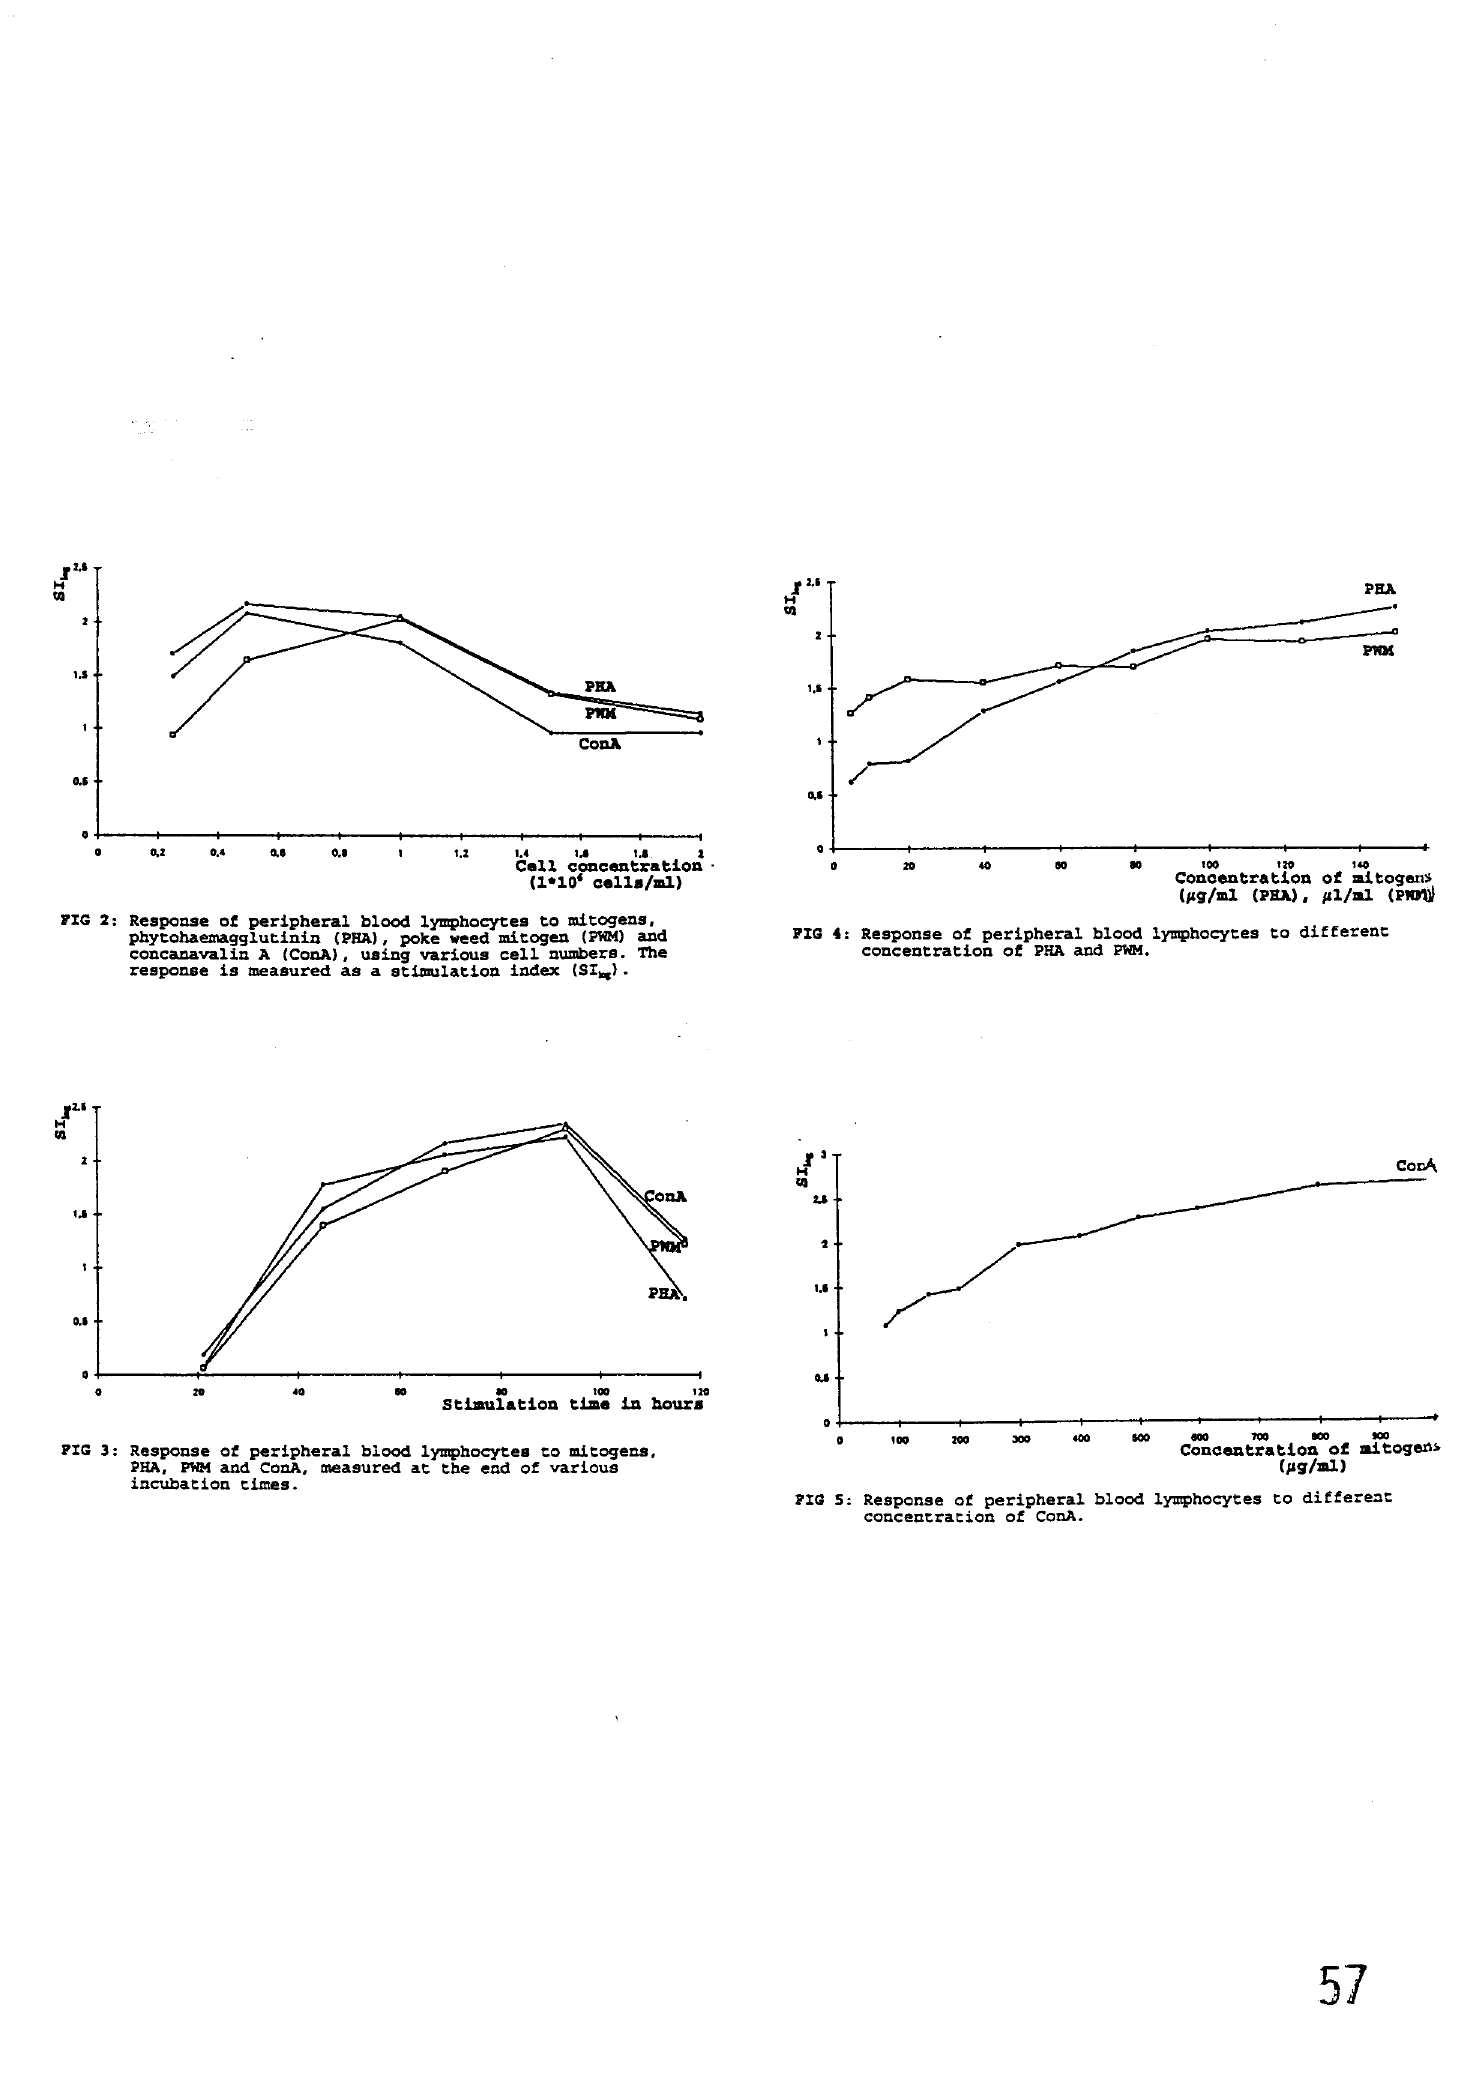
Concentration of mitogen* (pg/ml (PHA), nl /ml (PKH)} PIG 4: Response of peripheral blood lymphocytes to different concentration of PHA and